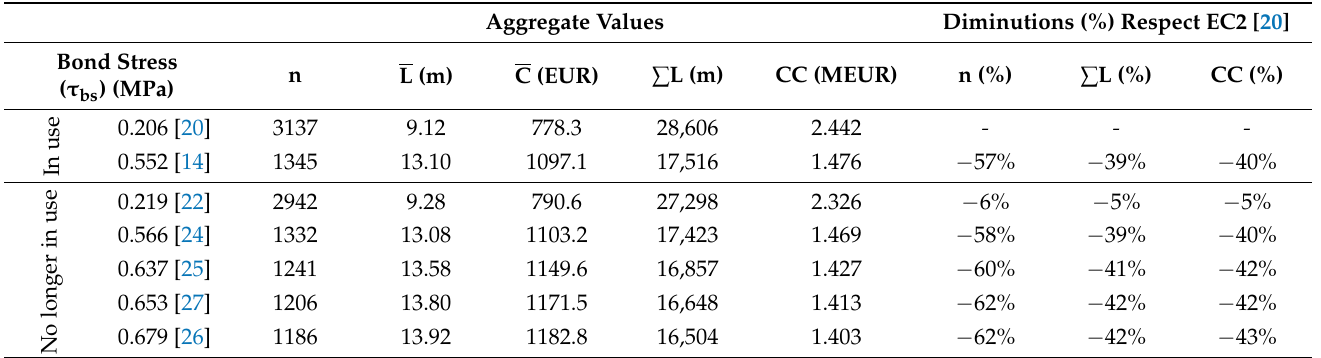
Table 4. Cost of foundation retrofit projects depending on the assumed bond stress formulation. Aggregate Values Diminutions (%) Respect EC2 [20] Bond